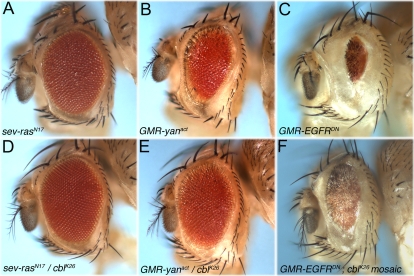
Genetic interaction between D-cbl and the EGFR pathway.(A,D) The rough eye caused by over-expression of dominant negative rasN17 under the sevenless promoter (sev-rasN17) (A) is considerably suppressed when heterozygous for D-cblK26 (D). Genotype in (D): sev-rasN17; D-cblK26/+. (B,E) The small eye phenotype caused by sevenless-induced expression of activated yan (sev-yanact) (B) is dominantly suppressed by heterozygosity for D-cblK26 (E). Genotype in (E): sev-yanact ; D-cblK26/+. (C,F) Overexpression of EGFRDN under the control of the GMR enhancer (GMR- EGFRDN) causes a small eye (C). Genotype: GMR-Gal4 UAS-EGFRDN. GMR-EGFRDN is recessively suppressed in D-cblK26 mosaics (F). Genotype: ey-Flp; GMR-Gal4 UAS-EGFRDN; D-cblK26 FRT80/P[ubi-GFP] FRT80.